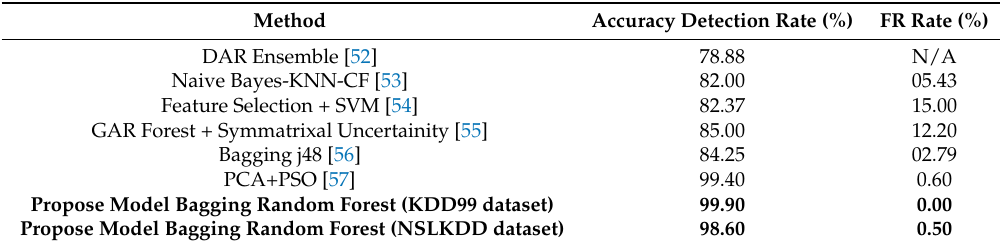
Table 47. Comparison analysis of our proposed model with other ensemble